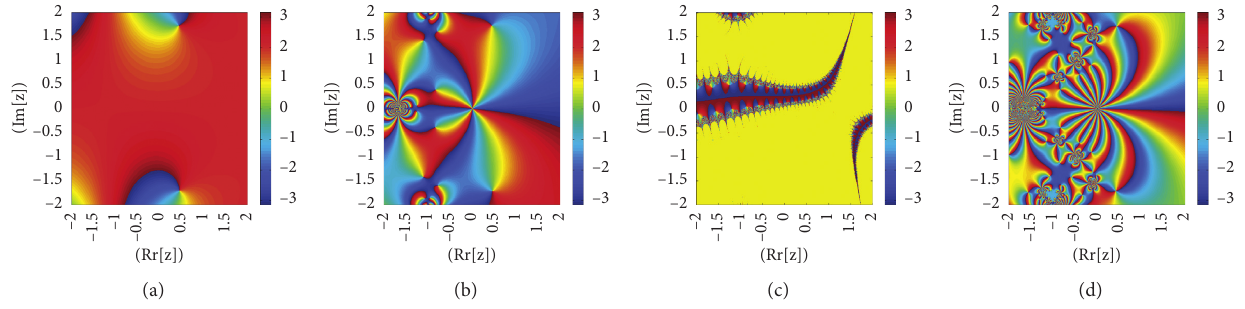
Figure 1: (a), (b), (c), and (d) show basins of attraction for nonlinear function f WDK2, and IWM2 respectively.